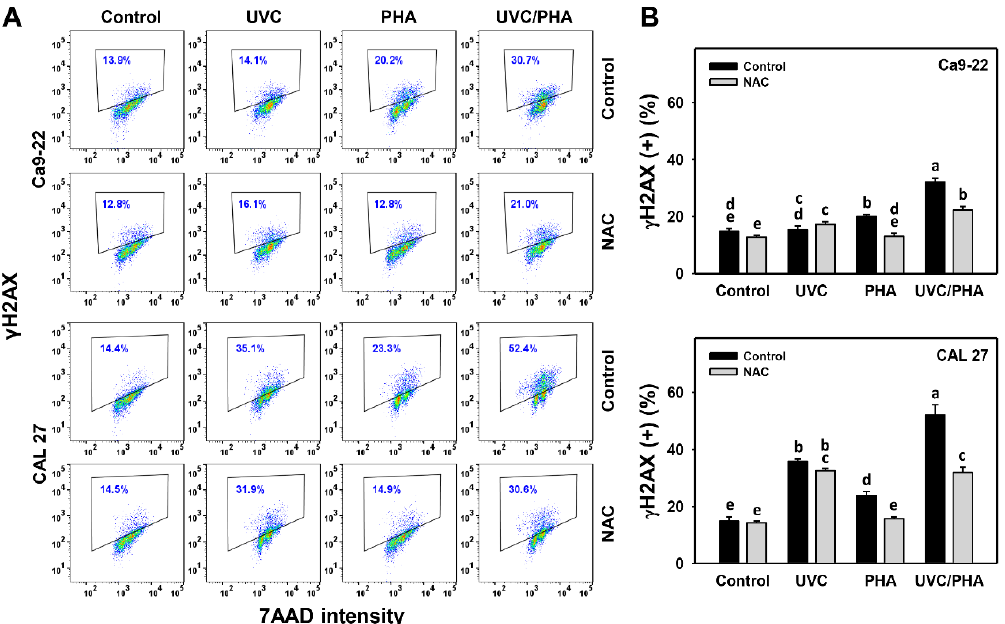
Figure 8. UVC/PHA-induced γ H2AX in oral cancer cells. In the presence or absence of NAC, oral cancer cells were grouped into four treatments, i.e., control, UVC, PHA, and UVC/PHA, for 24 h. The doses for the UVC and PHA treatments were 8 J/m 2 and 0.8 μ M, respectively. ( A , B ) Profile and data. Percentages within the boxes indicate γ H2AX-positive (%). For comparison, treatments labeled with different letters (a to e) produced significantly different results ( p < 0.05). Data are presented as mean ± SD ( n = 3 independent experiments, with each experiment involving 5000 gated cell counts).